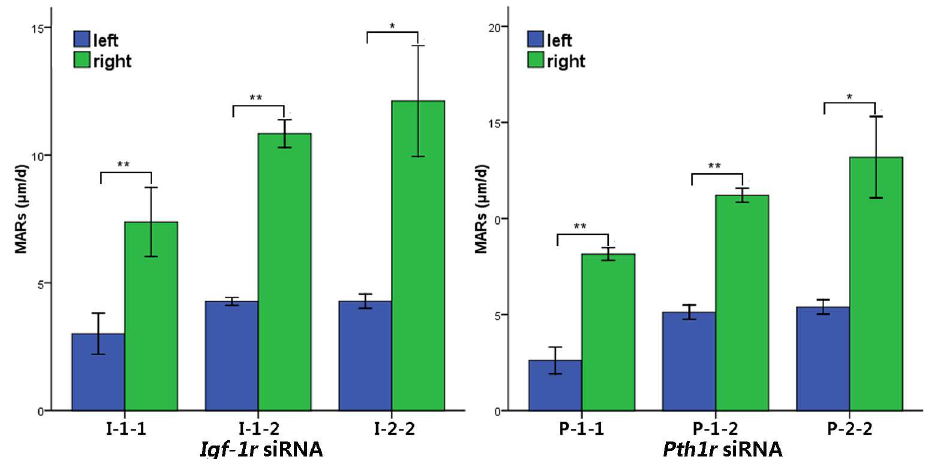
Fig 8. Quantification of MARs. In the Igf-1r and Pth1r siRNA transfectiongroups, quantification of the MAR revealed that Igf-1r or Pth1r siRNA injectionin the left tibias dramatically reducedthe bone formation rate comparedto the right tibias treated with IGF-1 or rhPTH (1–34) only (I-1-1 and P-1-1, one injectionfor one week; I-1-2 and P-1-2, one injectionfor two weeks; I-2-2 and P-2-2, two injections over two weeks). * p < 0.05 and ** p < 0.01.